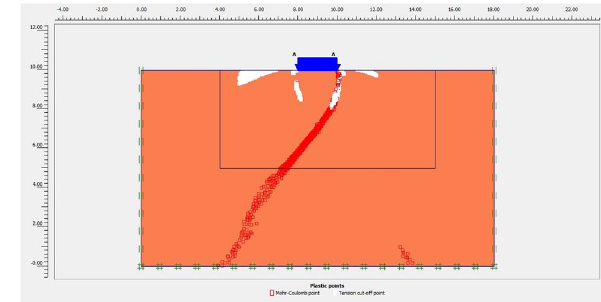
Fig. 25 Plastic points changes for the failed soil without contami-